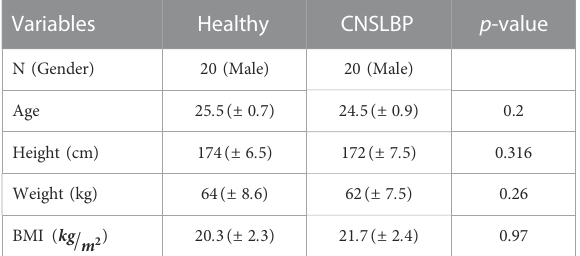
TABLE 1 Participants ’ demographic information for both healthy and low back patients. Variables